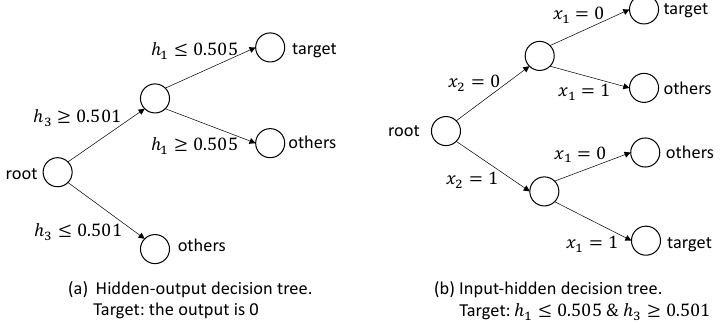
Figure 9. The hidden-output decision tree for the target y = 0 in the “XOR” data